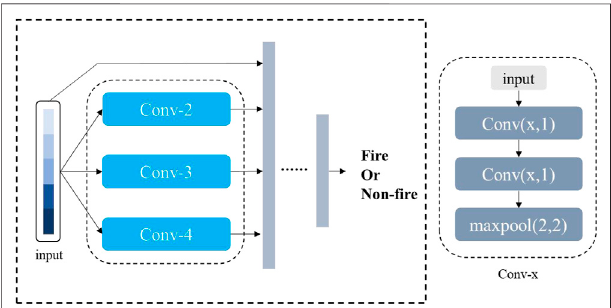
FIGURE 3 | Framework of the